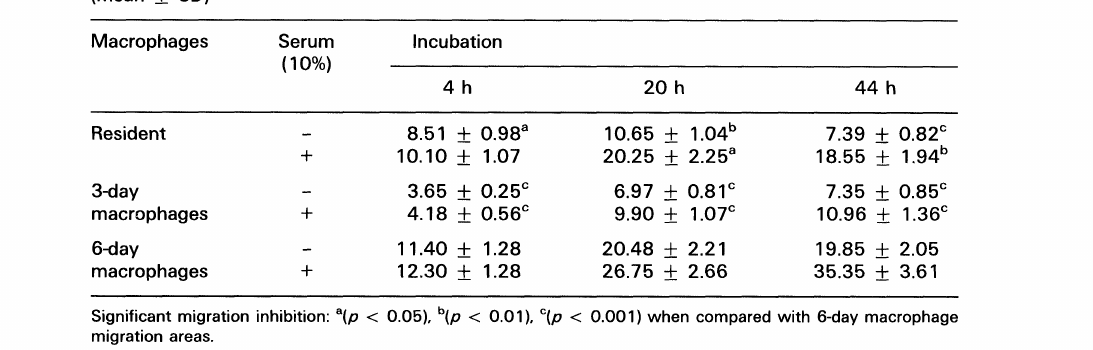
Table 1. The random migration of guinea-pig resident and elicited macrophages. Migration areas (mean